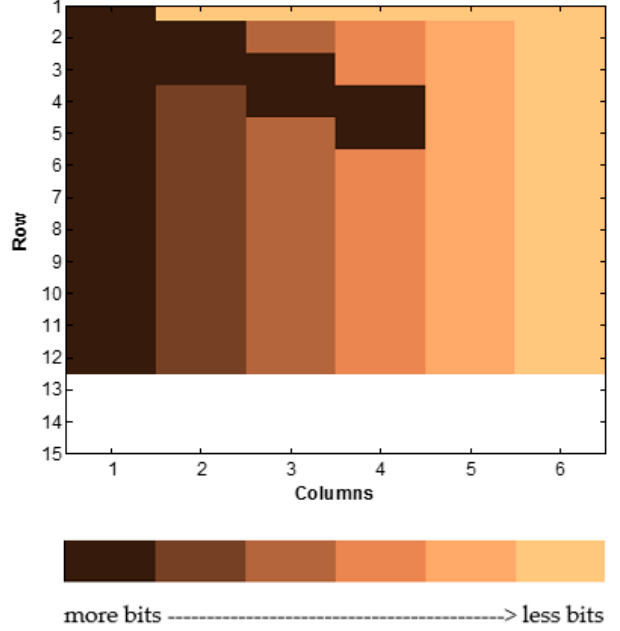
Figure 11. Bit allocation for rotation matrix (darker color means more bits needed; white color means no bits).